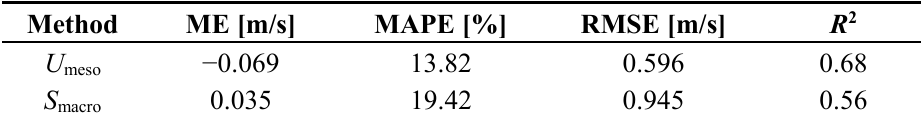
Table 2. Statistical details of the measurement errors for the U meso and S macro exposure correction